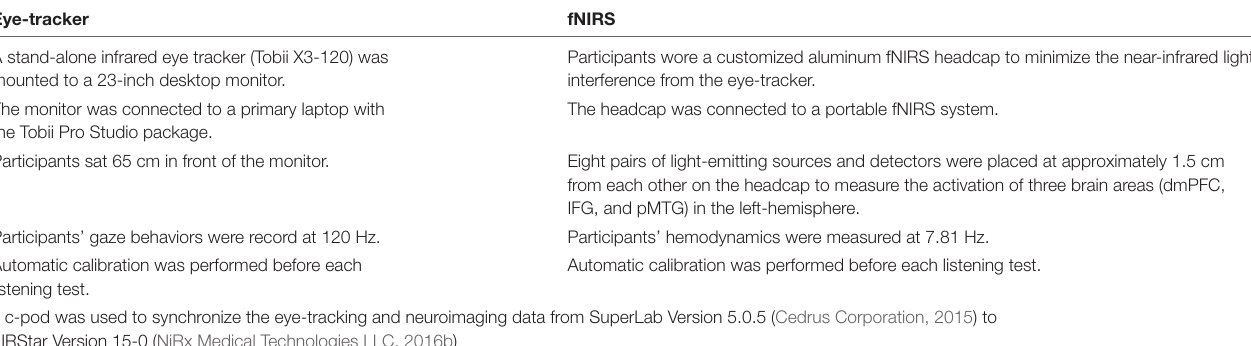
TABLE 1 | The setup of the eye-tracker and fNIRS used in the present study. Eye-tracker fNIRS